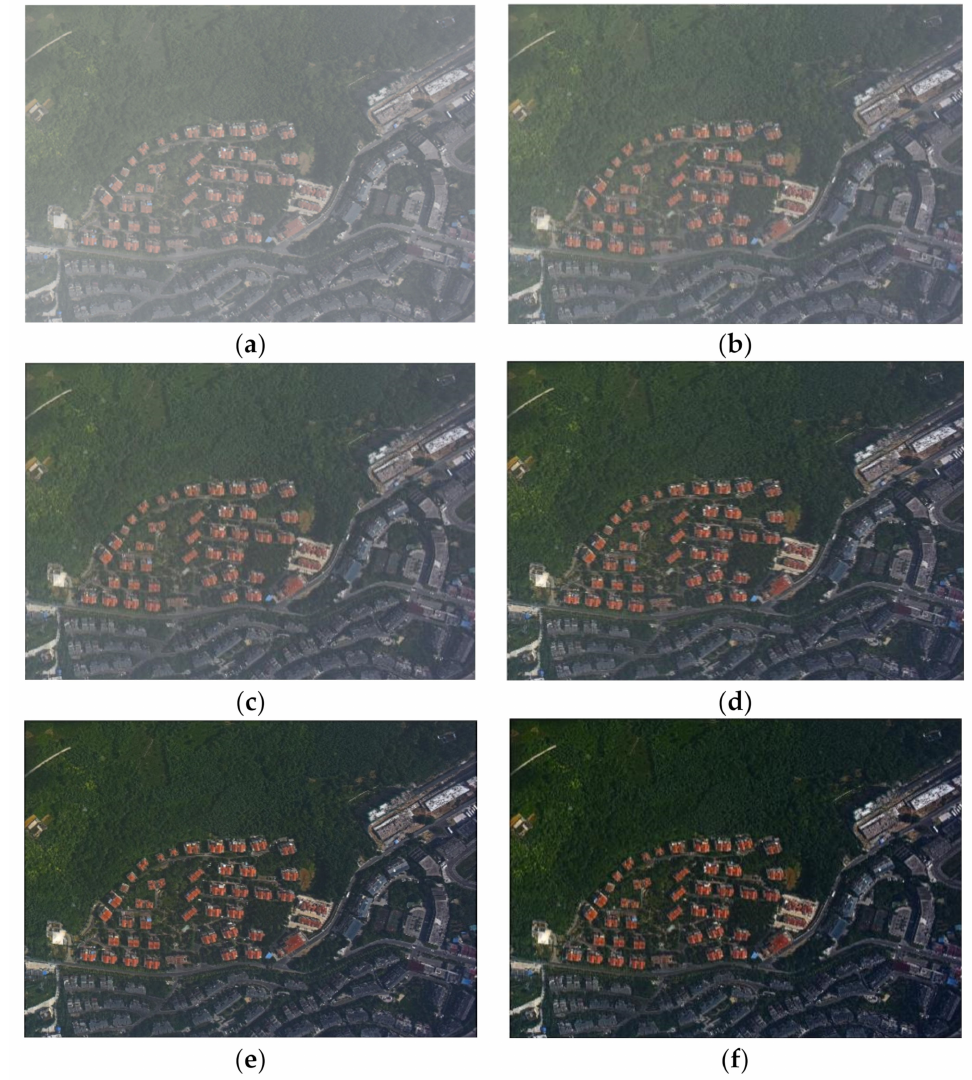
Figure 6. ( a ) Foggy remote sensing image; ( b ) ω = 0.65; ( c ) ω = 0.75; ( d ) ω = 0.85; ( e ) ω = 0.95; ( f ) ω = 1. To further verify the relationship between the defogging intensity parameter and atmo- spheric light value, many experiments are conducted. As shown in Figure 7, when ω = 0.65, the buildings of the coastal city are partially restored, the detailed information is prominent, and the water color is more natural and true. When ω = 0.75, the watercolor of the restored image starts to become darkened, and the color of the building is saturated. When ω = 1, the water color and part of the building are too saturated, and the distortion is aggravated, which is not suitable for human observation. In a comprehensive comparison, when ω = 0.65, the overall restoration effect is the best. At this time, the atmospheric light value A 0 of the original image in Figure 7 is estimated to be 0.6135 through the dark channel prior, which is the closest to the best defogging intensity parameter ω